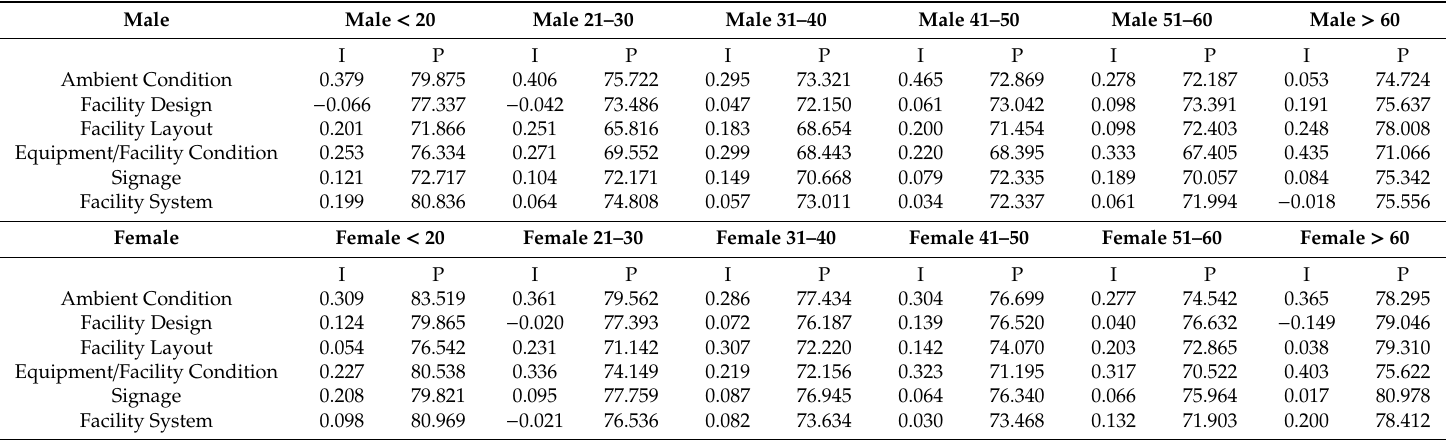
Table 7. IPMA results by sex and age